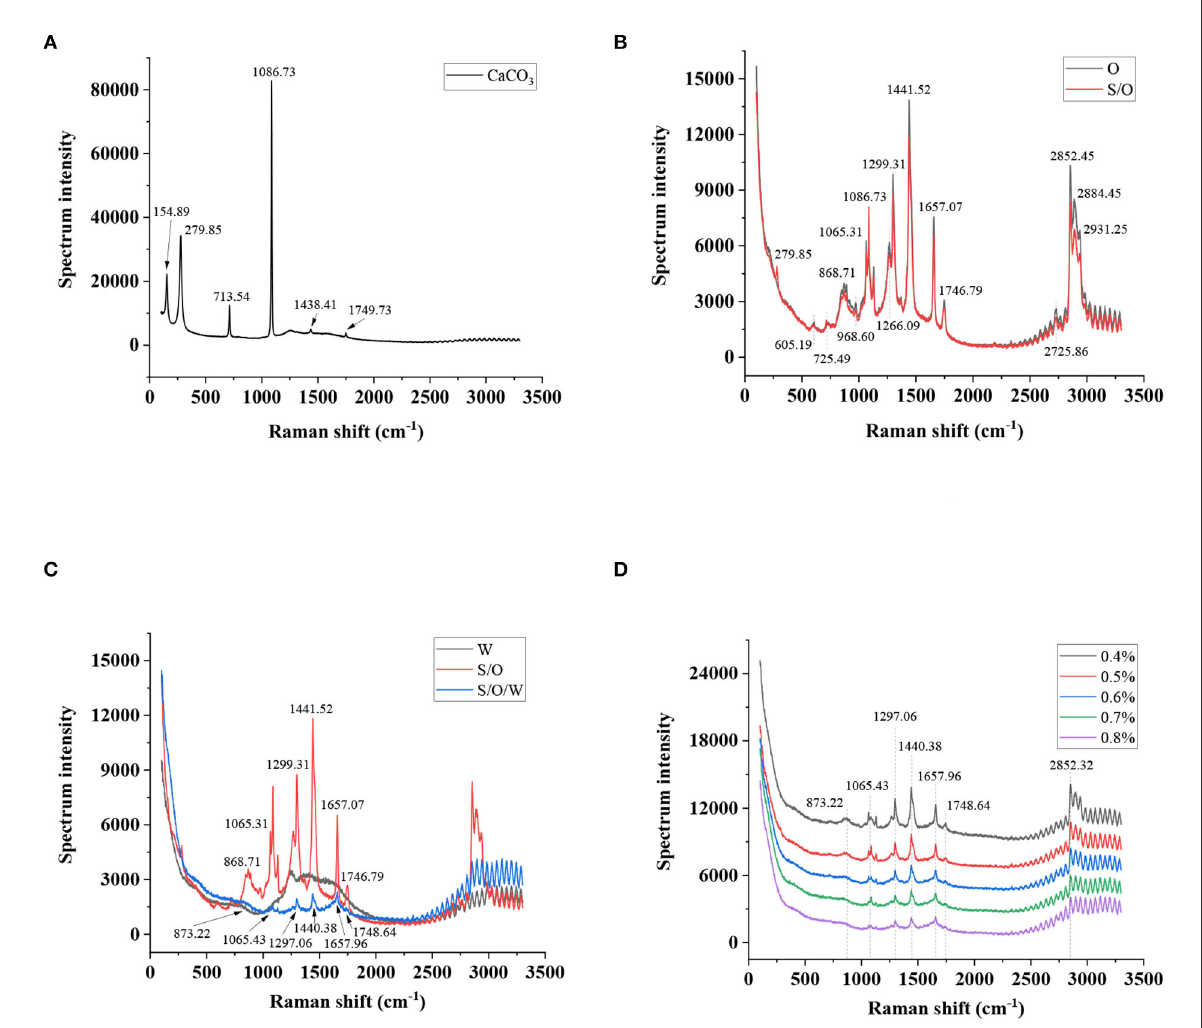
FIGURE7 Raman spectra of (A) CaCO 3 powders, (B) O phase and S/O phase, (C) W phase, S/O phase, and S/O/W calcium-lipid emulsion, and (D) S/O/W calcium-lipid emulsions formed by different concentrations of PGA-XG